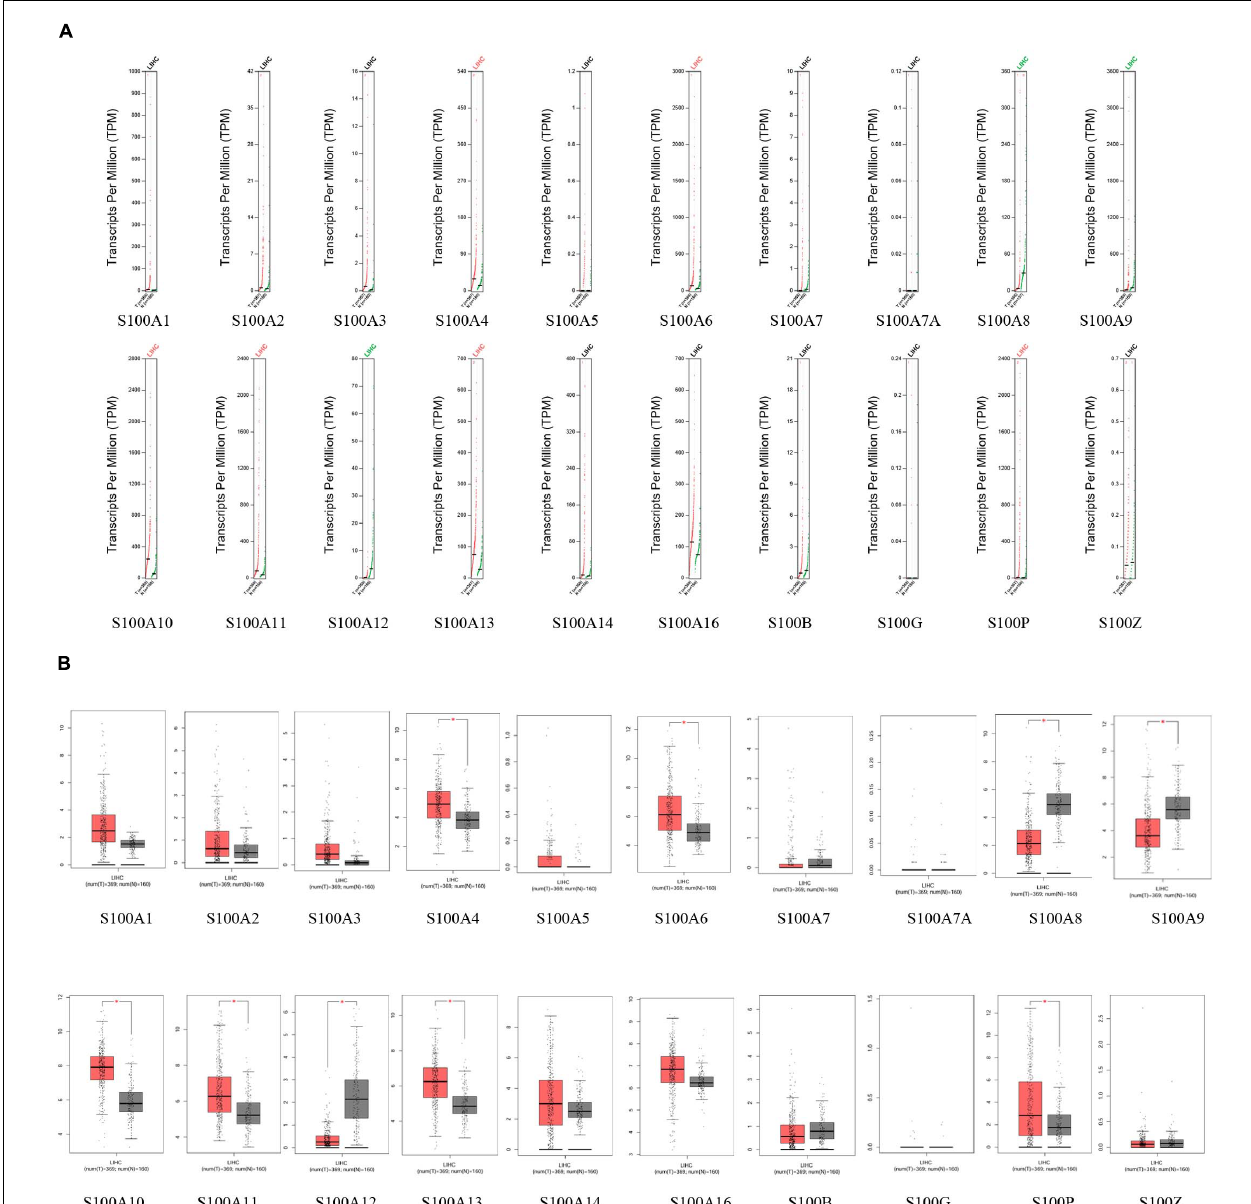
FIGURE 2 | The mRNA levels of S100s in hepatocellular carcinoma (HCC) (GEPIA database). The levels of S100A4/S100A6/S100A10/S100A11/S100A13/S100P were higher in tumor than in normal liver samples, while S100A8/S100A9/S100A12 were downregulated ( A , scatter diagram; B , box plot; * p < 0.01).